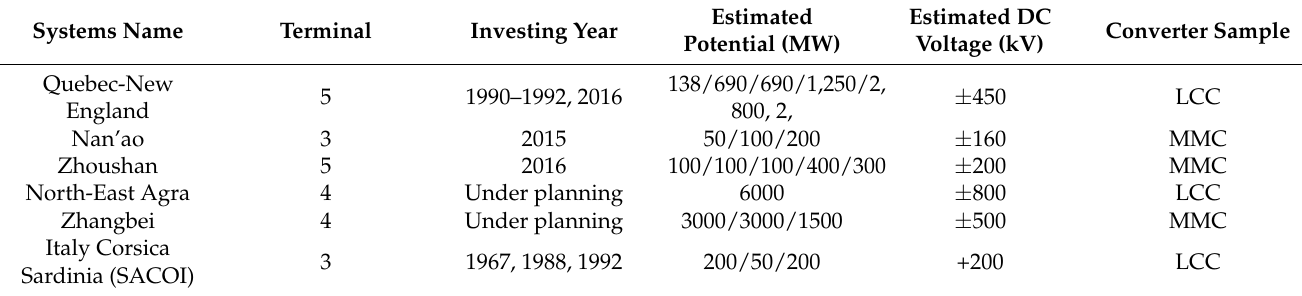
Table 4. Multi-terminal HVDC systems throughout the